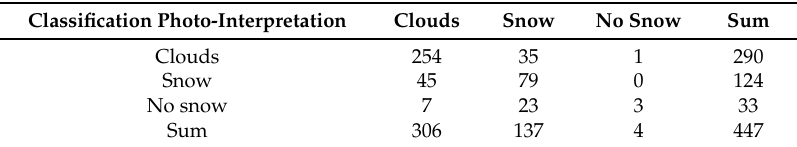
Table 5. Confusion matrix of MOD10 for comparison with PROBA-V.